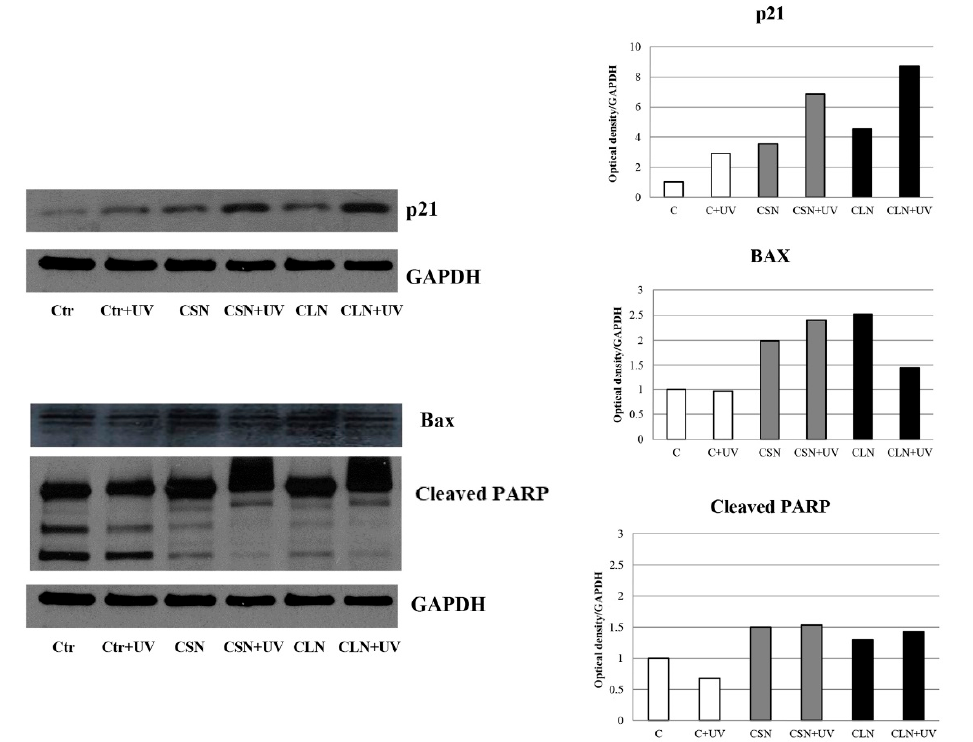
Figure 4. Western Blot analysis of p21, BAX and PARP (poly ADP-ribose polymerase) protein levels in C32 cells treated or not with CSN and CLN extracts for 24 h, both in the presence and absence of UV. The histograms refer to the densitometric analysis (OD) of the Western blot shown in the figure.